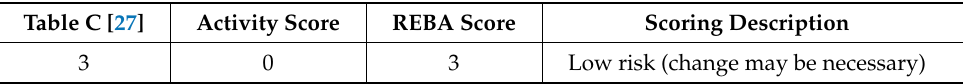
Table 11. REBA score after automation. Table C